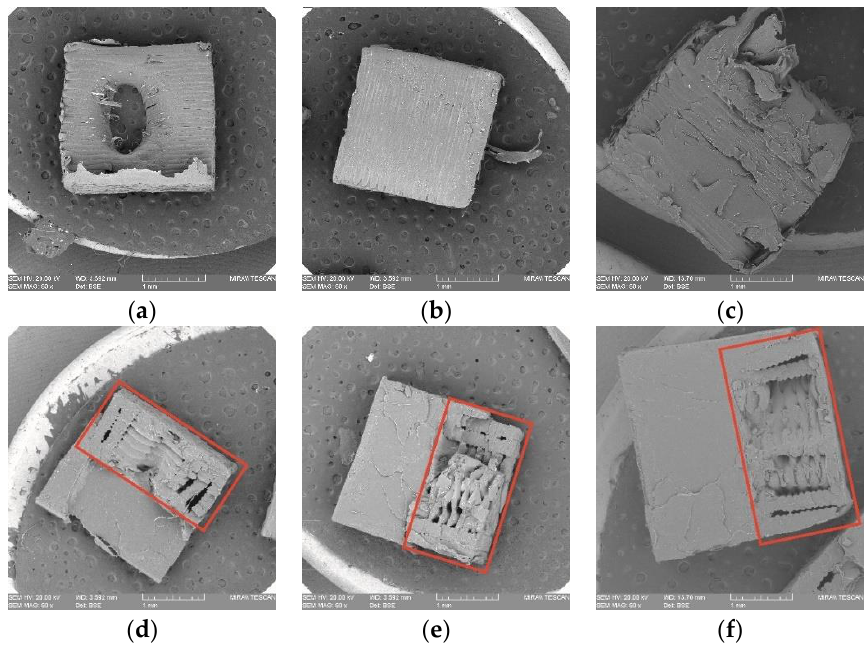
Figure 8. SEM observations on the fractured surfaces of ( a ) HL-NJ 25; ( b ) HL-NJ 50; ( c ) HL-NJ 75; ( d ) HT-NJ 25; ( e ) HT-NJ 50; ( f ) HT-NJ 75, in which the FDM preforms have been contoured using red square for HT series.